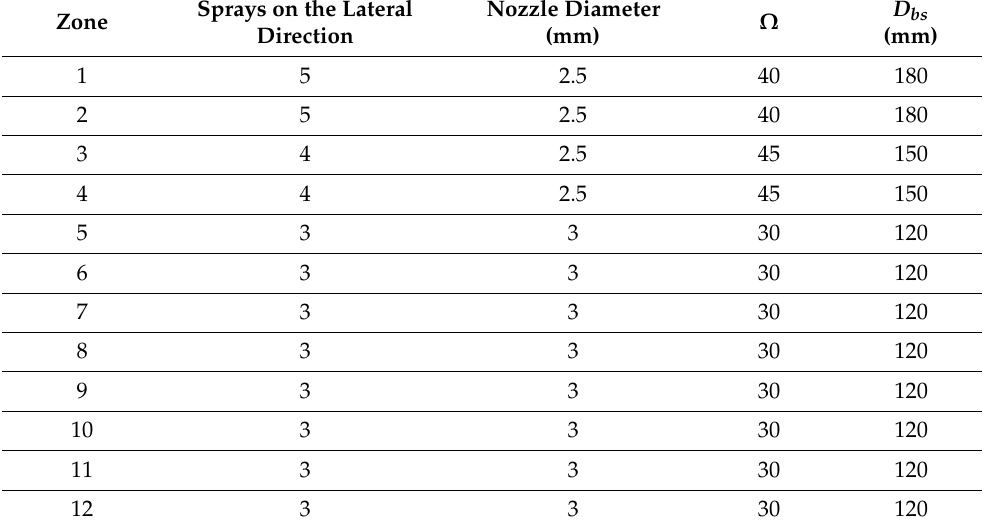
Table 8. Operating conditions of the SCS in the curve zone (for